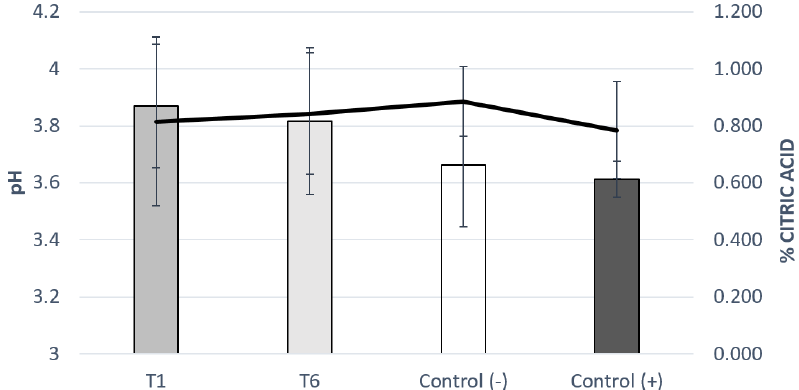
Figure 3. pH and acidity values (% of citric acid) registered at day 5 of storage. Legend: Control (−): fruit slices, no pathogens, no peptide; Control (+): fruit slices+ indicator cocktail; T1: fruit slices treated with indicator cocktail + formulation T1 (CFS); T6: fruit slices treated with indicator cocktail + formulation T6 (PP); T1: Cys5-4CFS+ Gt28CFS:1:1 (v/v); T6: Cys5-4PP + Gt28PP:1:1 (v/v).